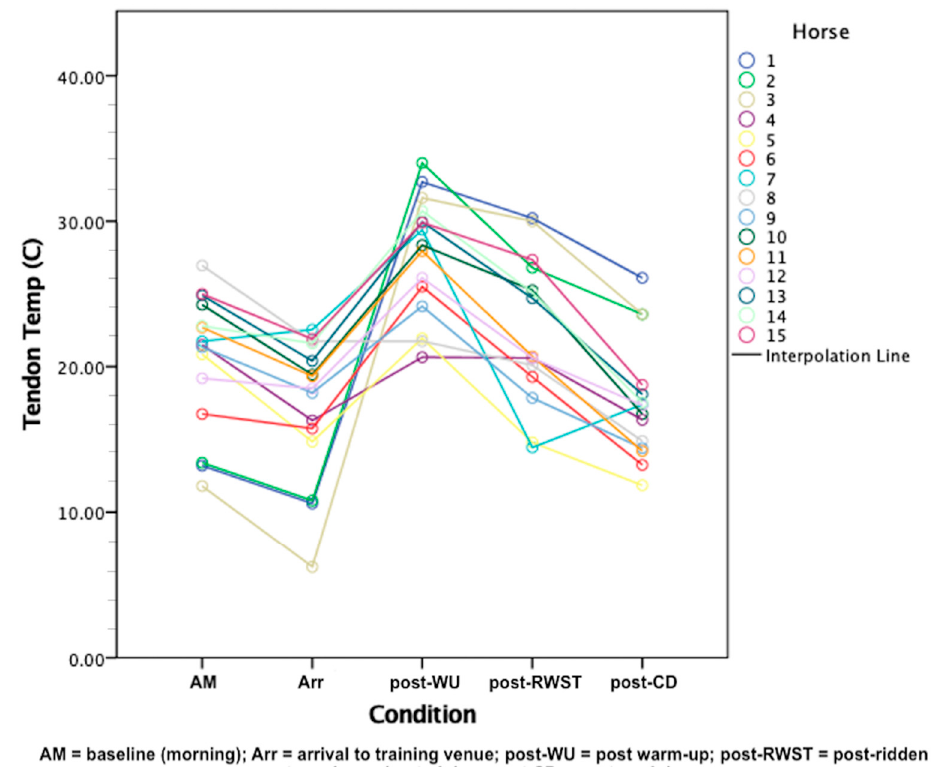
Figure 5. Distal limb temperature recorded per horse by condition.